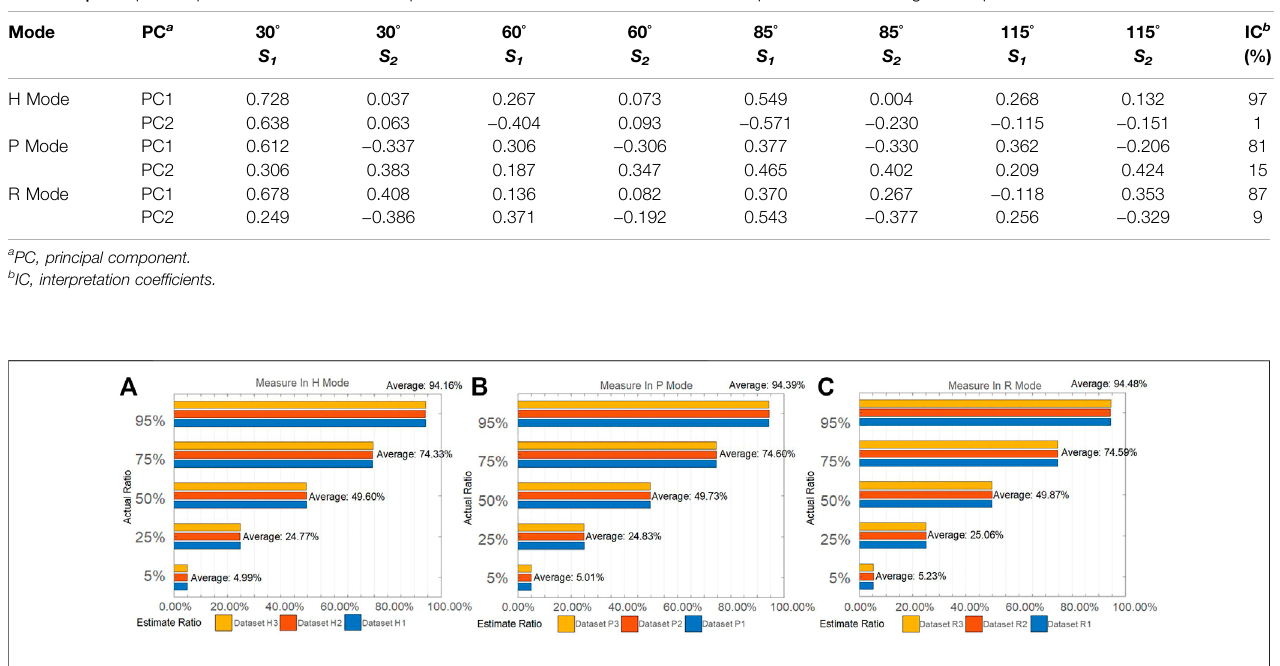
FIGURE 4| True and predicted proportion ofpollen using PC1 from MAPIS. (A) Measurement conducted in H mode; (B) Measurement conducted in P mode; (C) Measurement conducted in R mode.